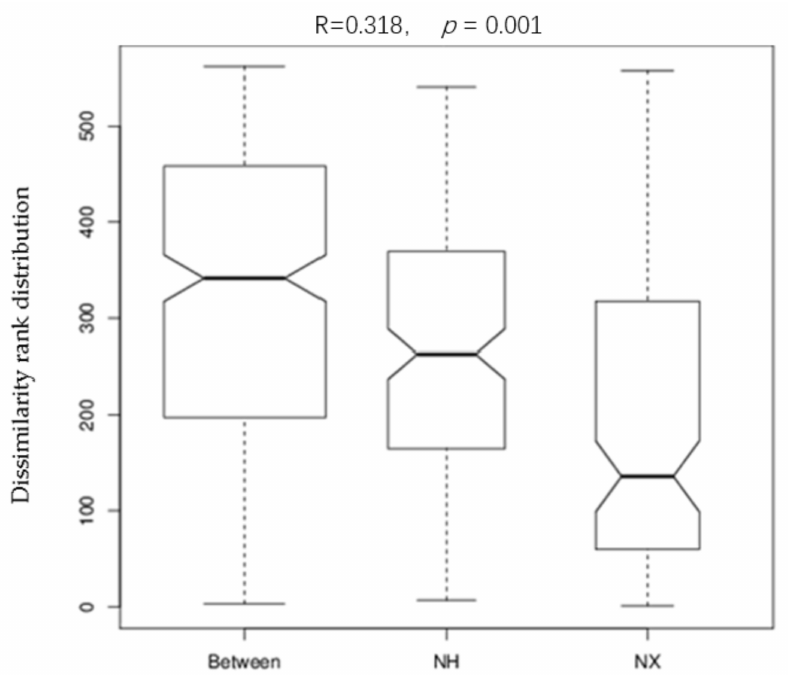
Figure 3. Anosim analysis of bacterial 16S rRNA gene sequence tags for colostrum samples from the X and H dairy farms. Note: NX ( n = 16) and NH ( n = 18) represented the colostrum samples from dairy farm X and dairy farm